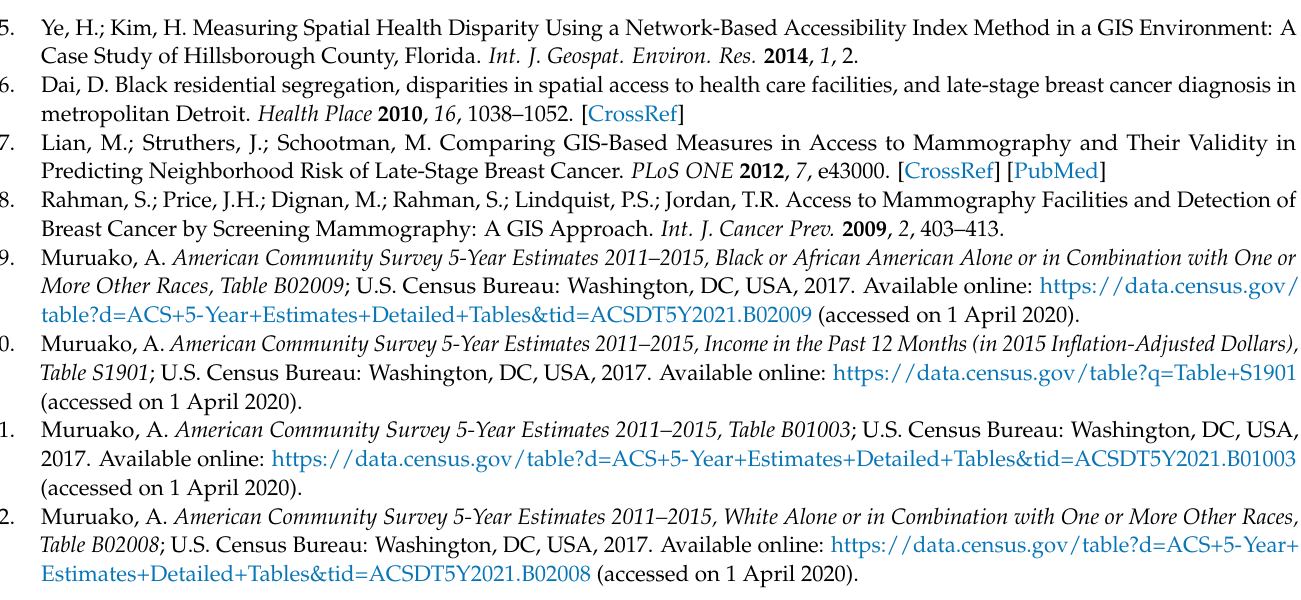
Table S1901 ; U.S. Census Bureau: Washington, DC, USA, 2017. Available online: